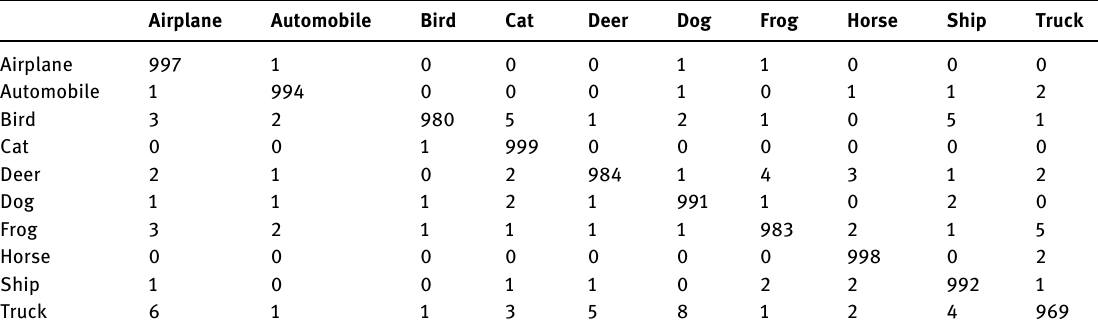
Table 7: The confusion